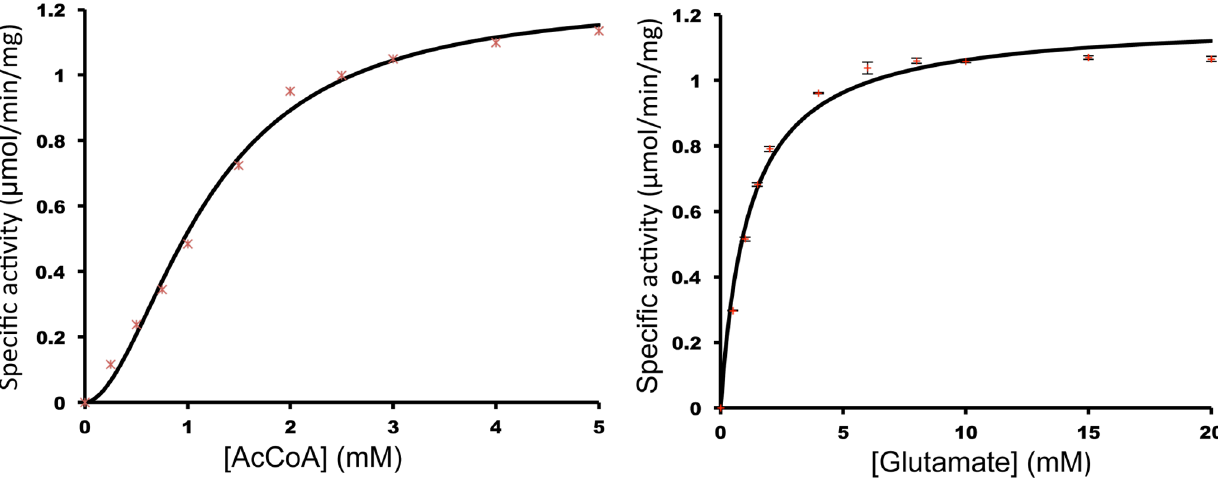
Figure 1. Biochemical properties of hNAT. A and B, dependence of enzyme activity on the concentration of AcCoA or L-glutamate. AcCoA or L- glutamate was varied in the range of 0.25–5.0 and 0.50–20.0, respectively, with L-glutamate and AcCoA fixed at 10 or 2.5 mM, respectively.